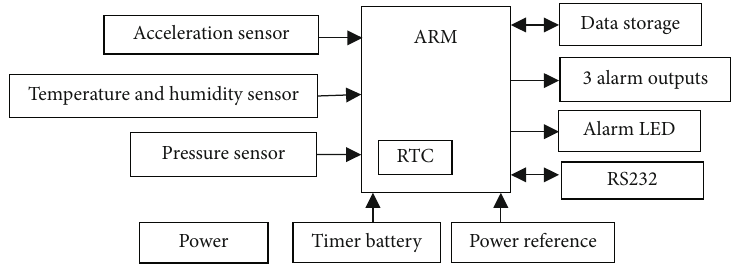
Figure 3: The principle block diagram of the shock and vibration acceleration recorder.